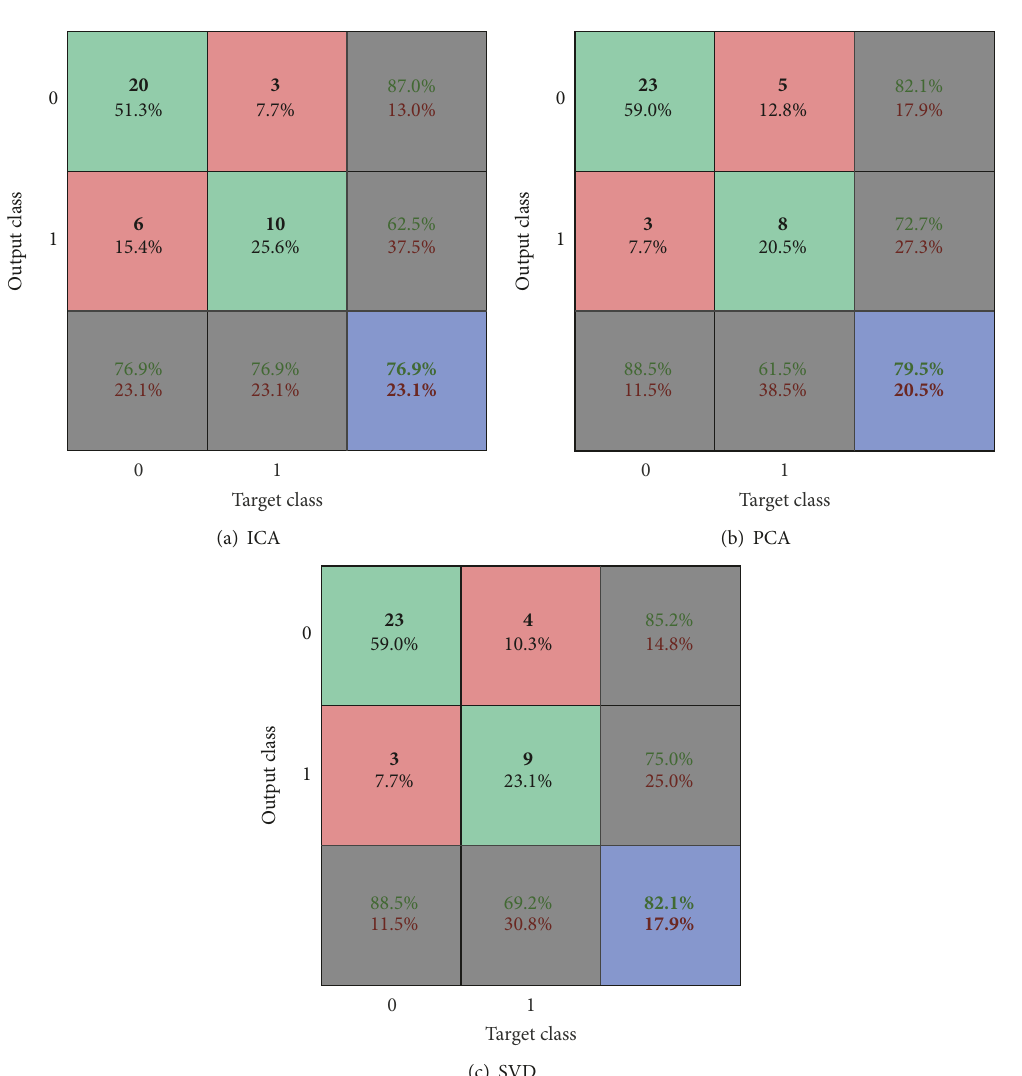
Figure 16: Confusion matrices of classification using the Gaussian Naive-Bayes for ICA, PCA, and SVD data reduction